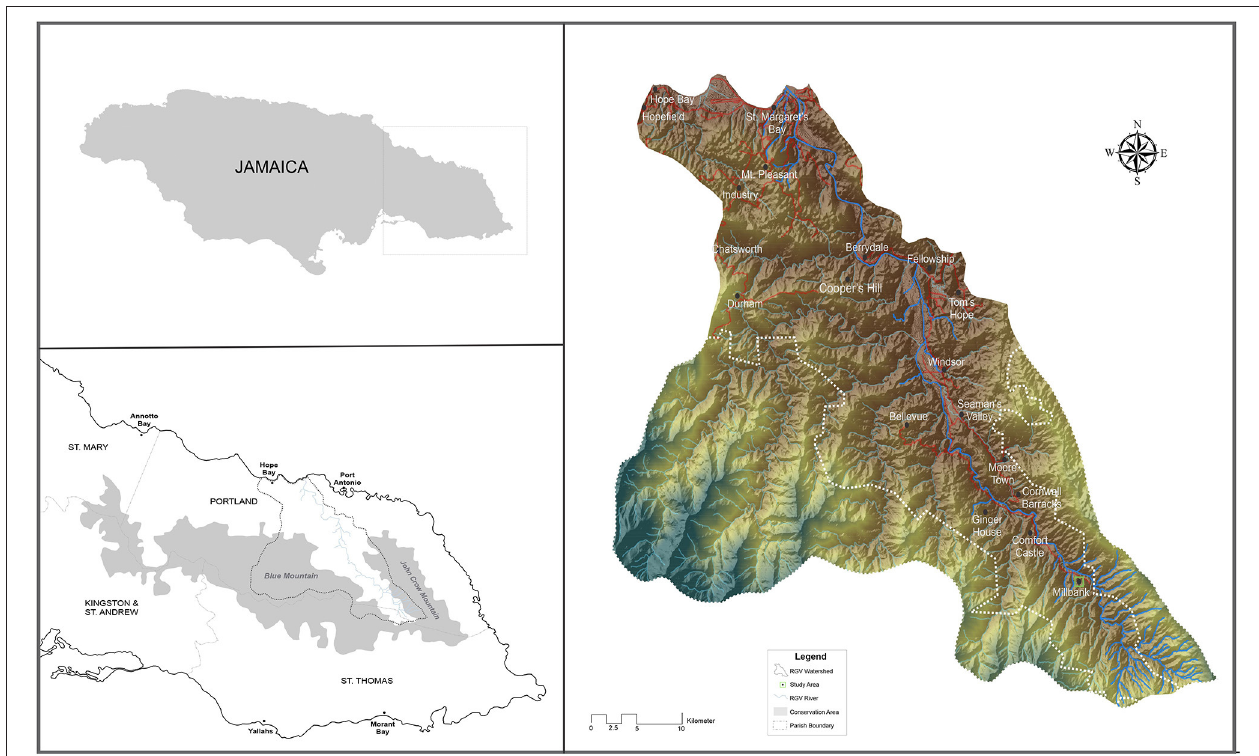
FIGURE 1 | Millbank, Upper Rio Grande Valley, Jamaica.